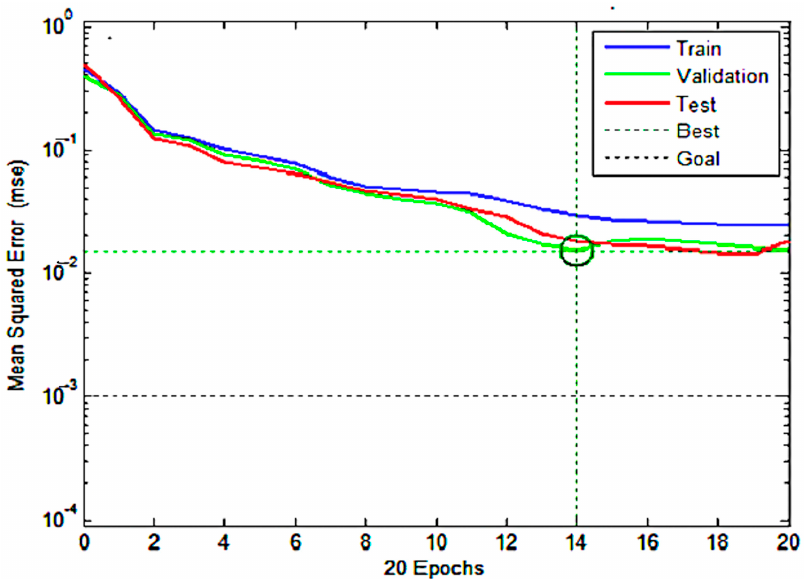
Figure 4. Training Phase performance of the proposed MLANN.